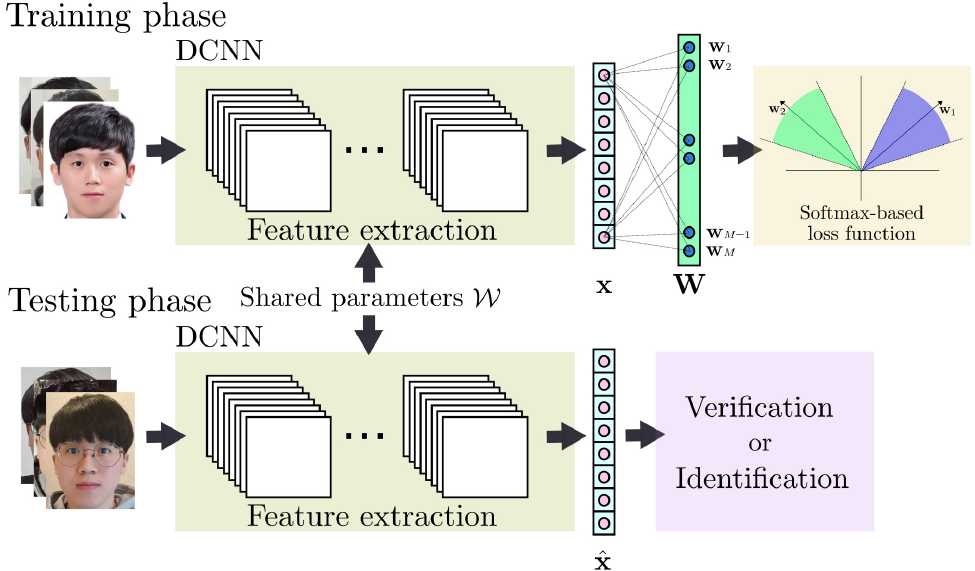
Figure 1. Deep face recognition (FR) system